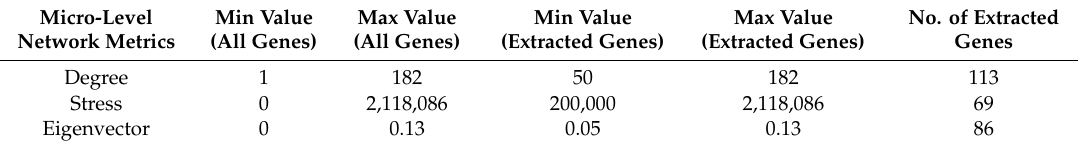
Table 1. The characteristics of analysis of 1481-gene (all genes) PPI network based on micro-level network